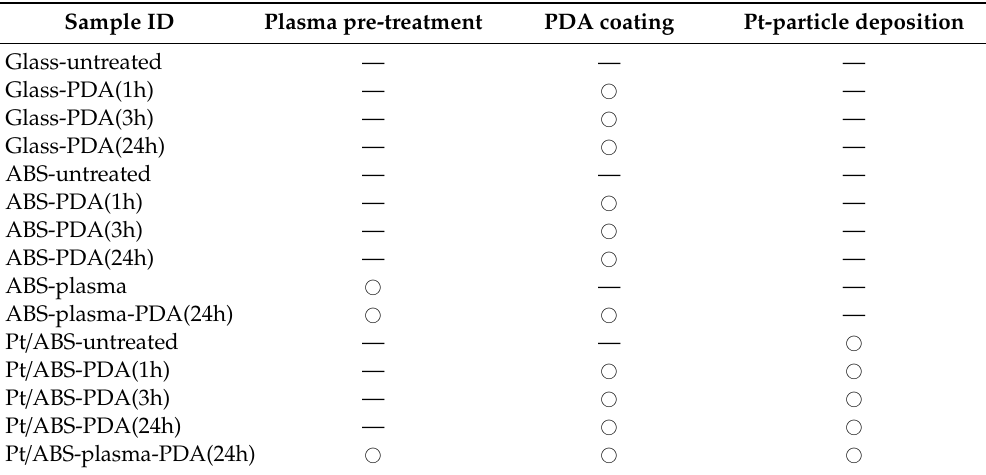
Table 2. Sample conditions and